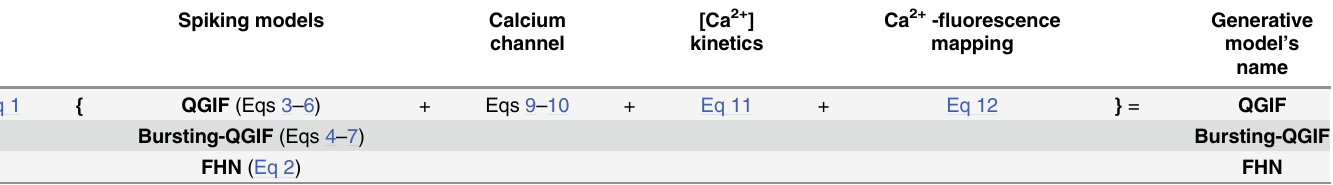
Table 3. Generative